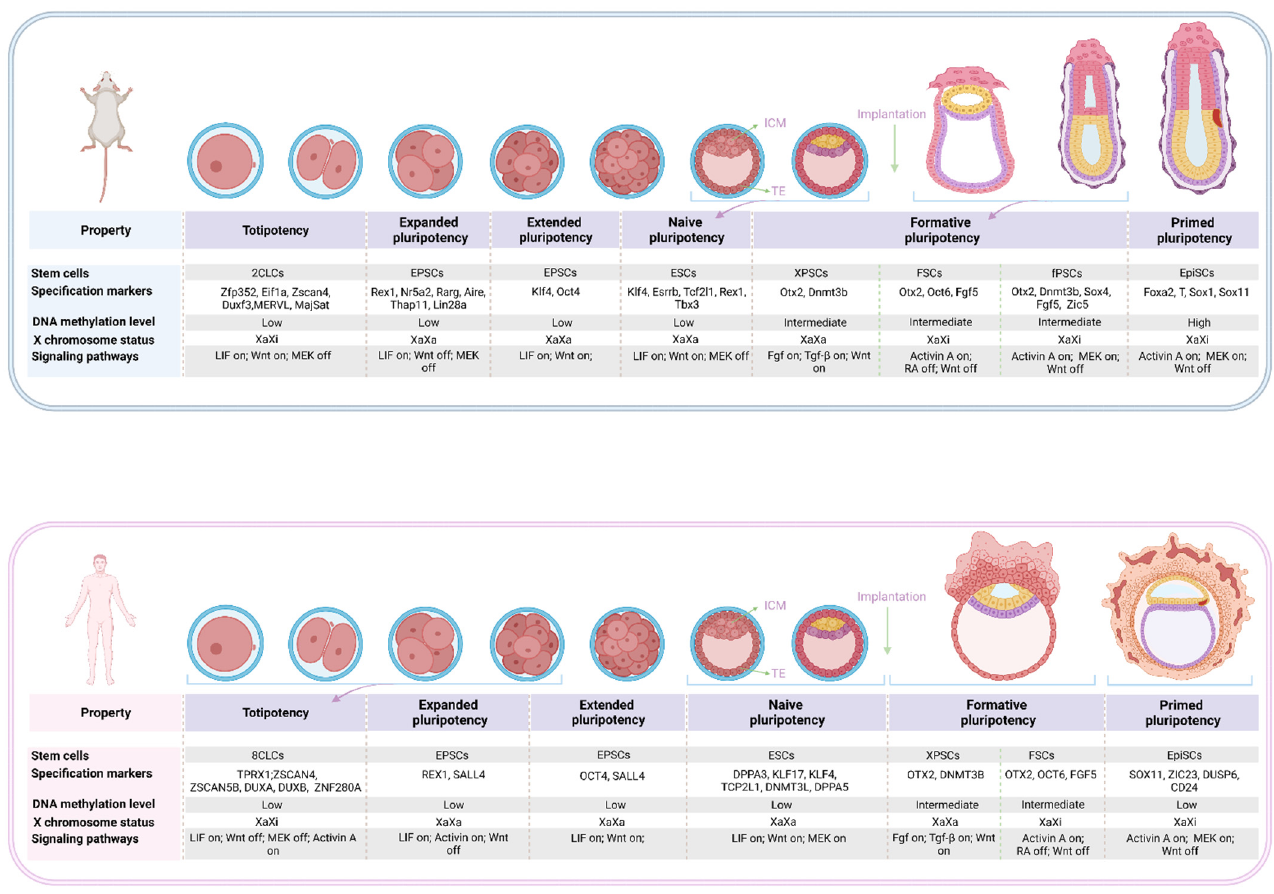
Figure 1. The divergent pluripotent